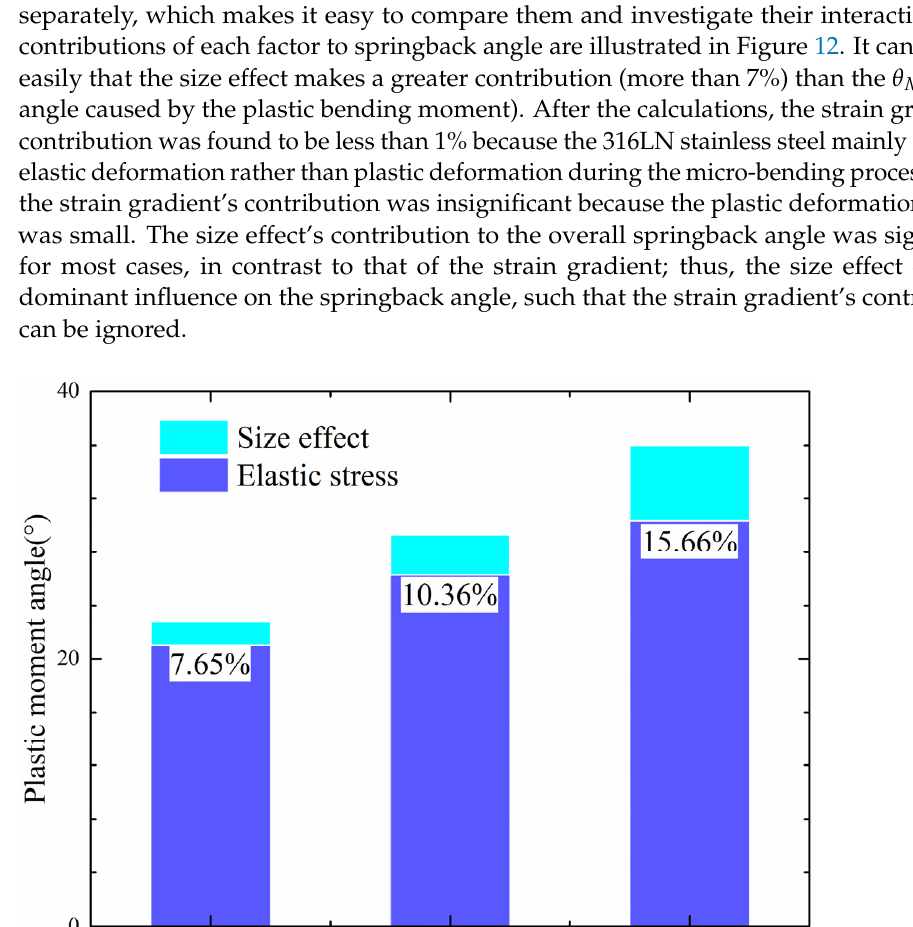
Figure 13. The contribution of strain gradient to springback in sheet metal samples with different grain sizes.